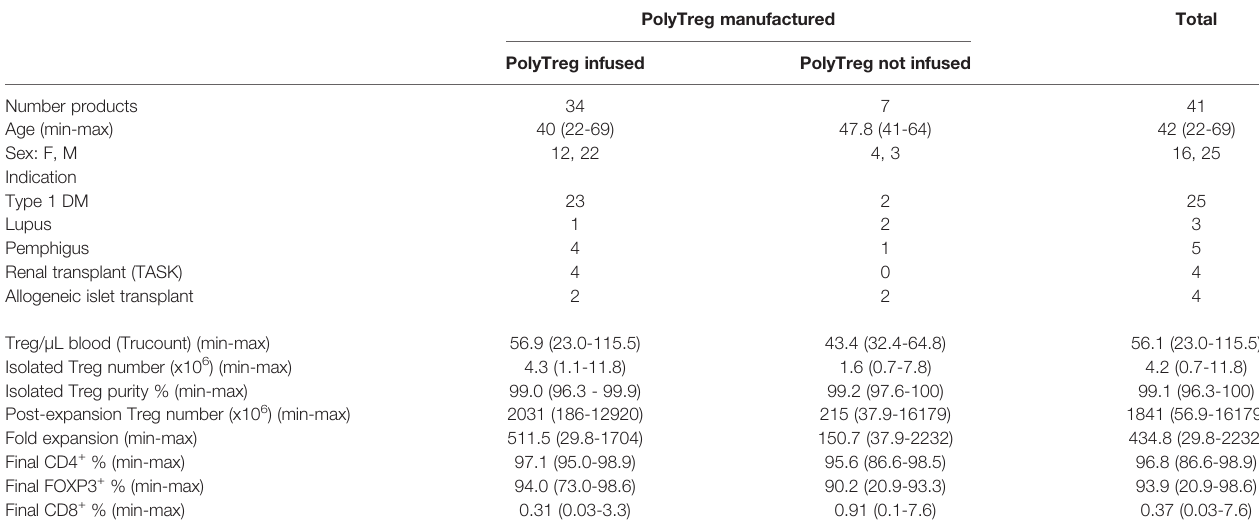
TABLE 1 | Manufacturing outcomes of PolyTregs by infused ( fi rst column), not infused (second column) or total (third column)